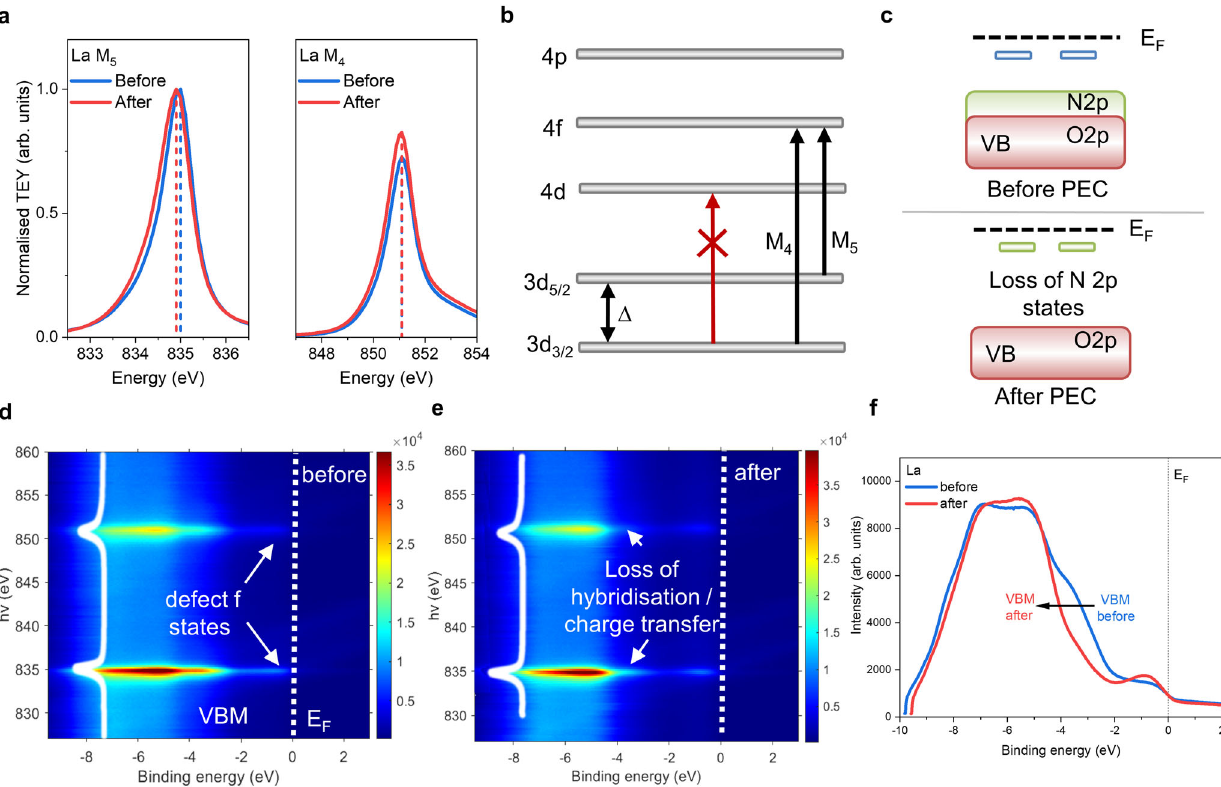
Fig. 4 Lanthanum A cation resonant SX-ARPES. a XAS spectra for LTON showing the La M 5 and M 4 edges, respectively. b Schematic representation of the transitions of the M 4 and M 5 absorption bands. c Schematic representation of the La contribution to the band structure of LTON. d La resonance (angle-integrated) PE intensity map before PEC. e After PEC. f Angle-integrated plots for data shown in parts d , e